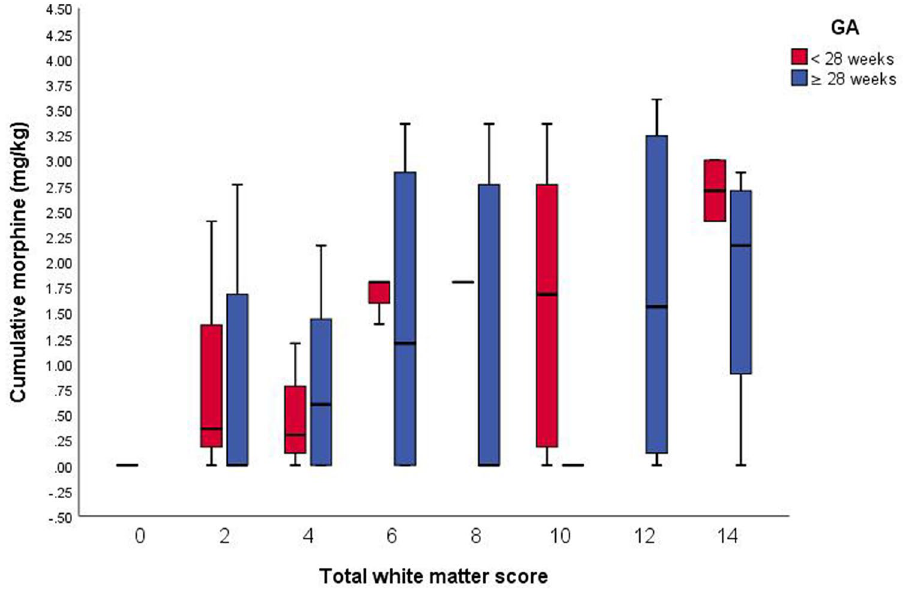
Figure 4. Total white matter score by morphine exposure, adjusted for age at the time of magnetic resonance imaging and stratified by gestational age (GA) at birth (red: < 28 weeks, blue: ≥ 28 weeks). GA Gestational